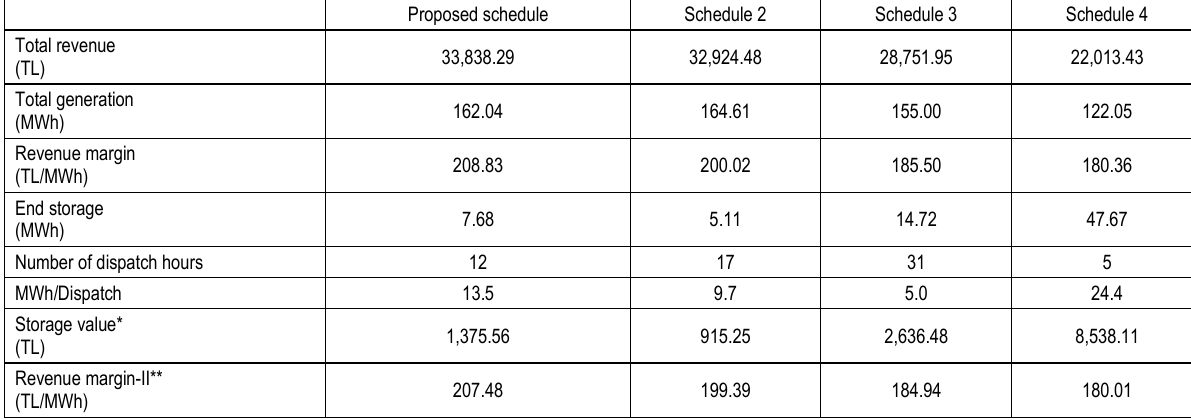
Table 4. Case results for 4 different dispatch